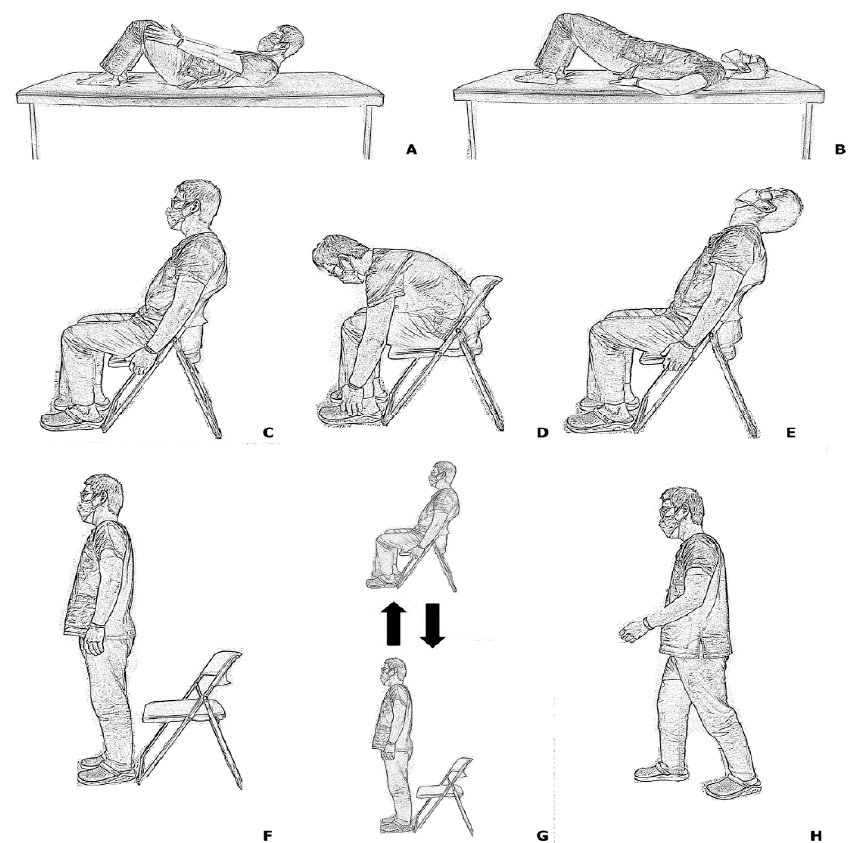
Figure 3. Illustration of proposed physical examinations: ( A ) forward bending in supine (FB-SU), and ( B ) backward bending in supine (BB-SU); ( C ) sitting for 5 s (SIT), ( D ) forward bending in sitting (FB-SI), and ( E ) backward bending in sitting (BB-SI); ( F ) standing for 5 s (STAND), ( G ) sitting to standing, standing to sitting (SIT-STAND), and ( H ) walking for 10 s (WALK).